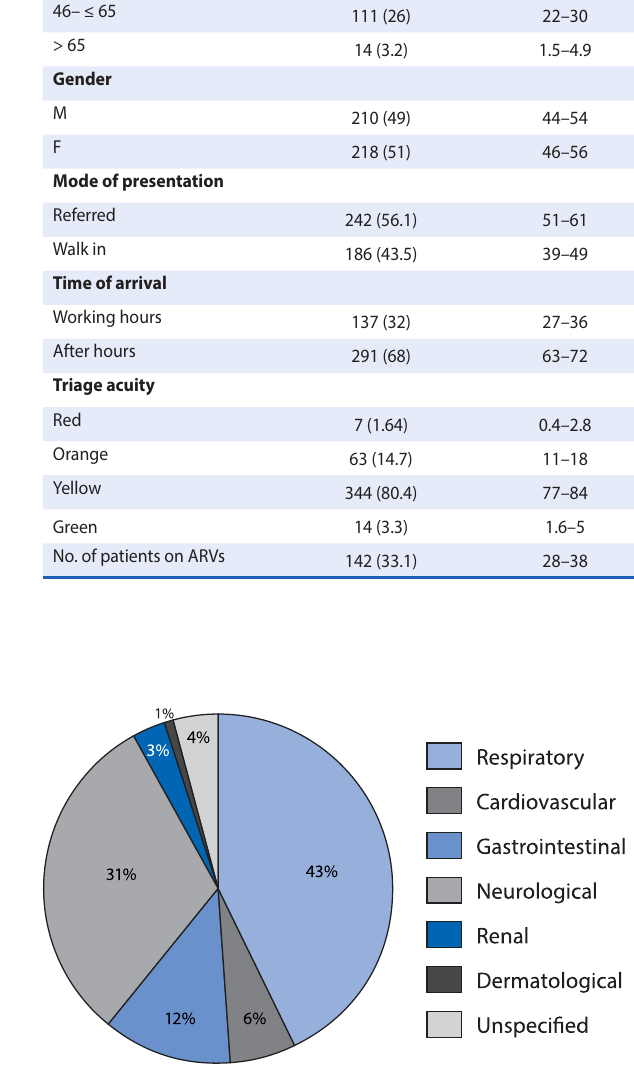
Figure 2: Disease aetiology per